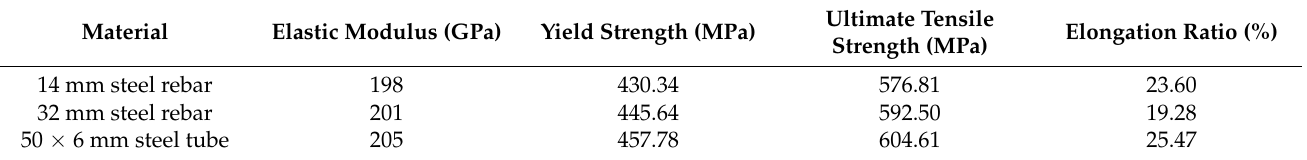
Table 5. Mechanical properties of the steel